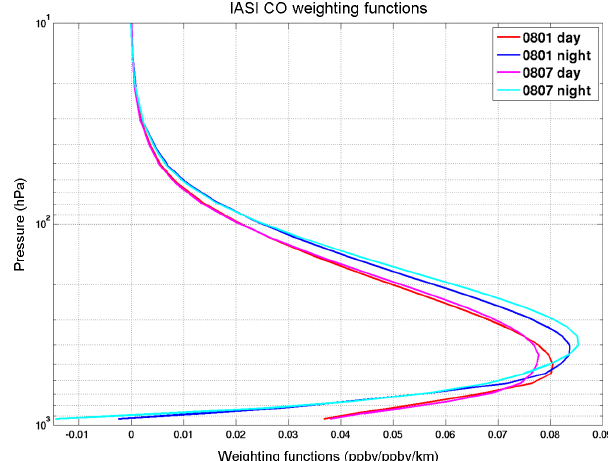
Figure 9. IASI CO weighting functions (ppbvppbv − 1 km − 1 ) , aver- aged over southern Africa, on land. Red: January by day (09:30LT). Blue: January by night (21:30LT). Magenta: July by day. Cyan: July by